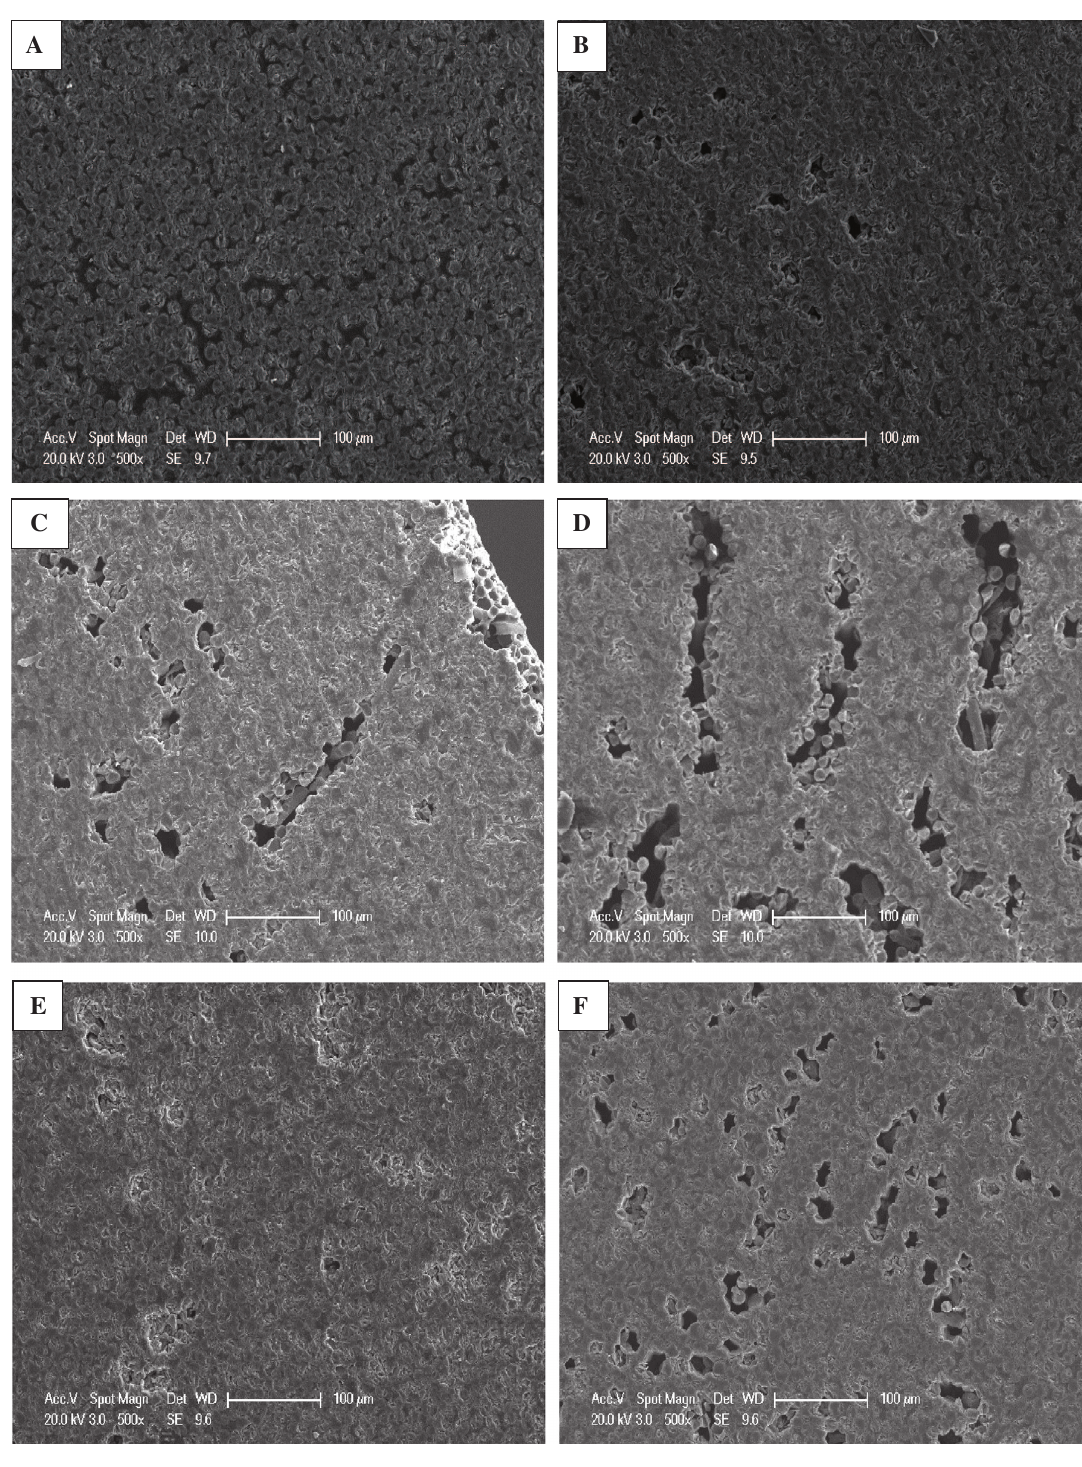
Figure 12: Scanning electron microscopy (SEM) images of basalt fiber-reinforced polymer (BFRP) bars: (A) BDSM-WD bars; (B) BDSM-CI bars; (C) BE-WD bars; (D) BE-CI bars; (E) BMFE-WD bars; (F) BMFE-CI bars. CI, continuous immersion; WD,